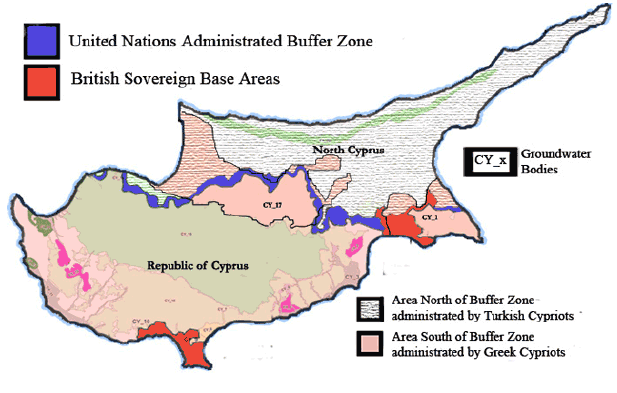
Fig. 3 . The four self-administrative entities and the groundwater bodies of Cyprus. The boundaries of the shared CY_1 and CY_17 are